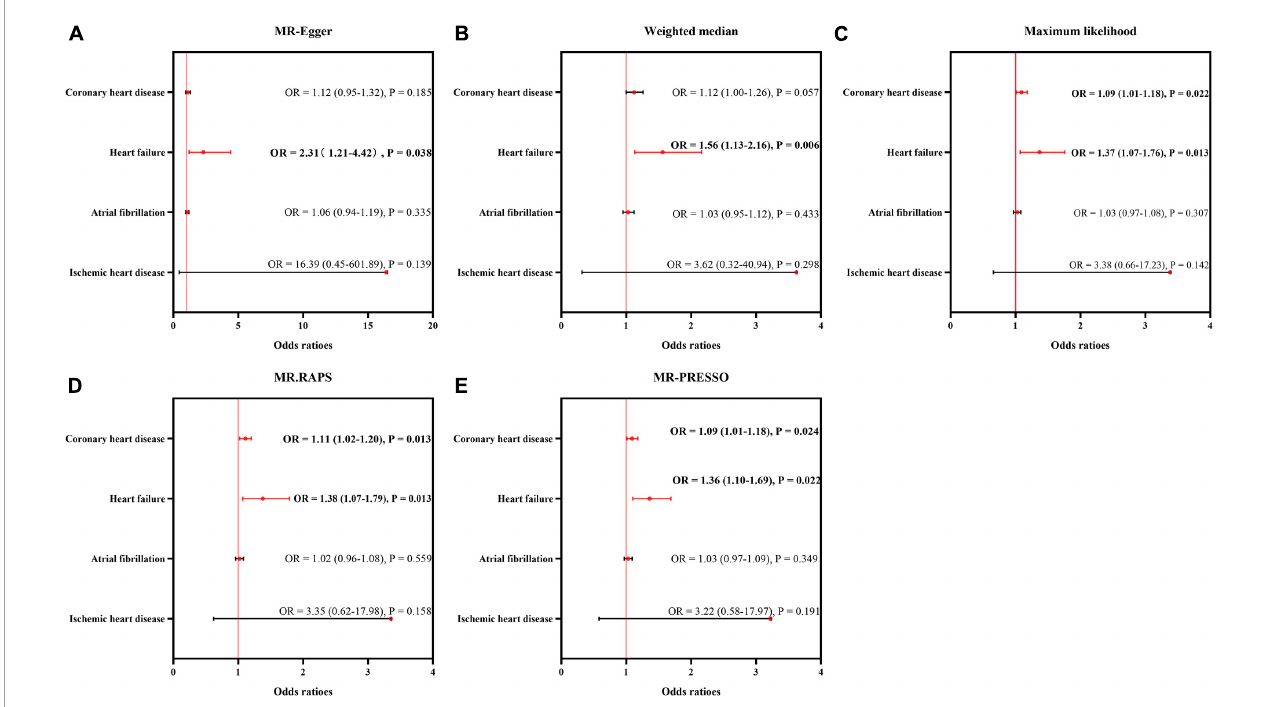
FIGURE3 Sensitivity analysis for the causality of cardiovascular diseases on ED. The results of MR-Egger (A) , weighted median (B) , maximum likelihood (C) , MR.RAPS (D) , and MR-PRESSO (E) . MR, Mendelian randomization; MR-PRESSO, MR Pleiotropy Residual Sum and Outlier; MR.RAPS, robust adjusted profile score; OR, odds